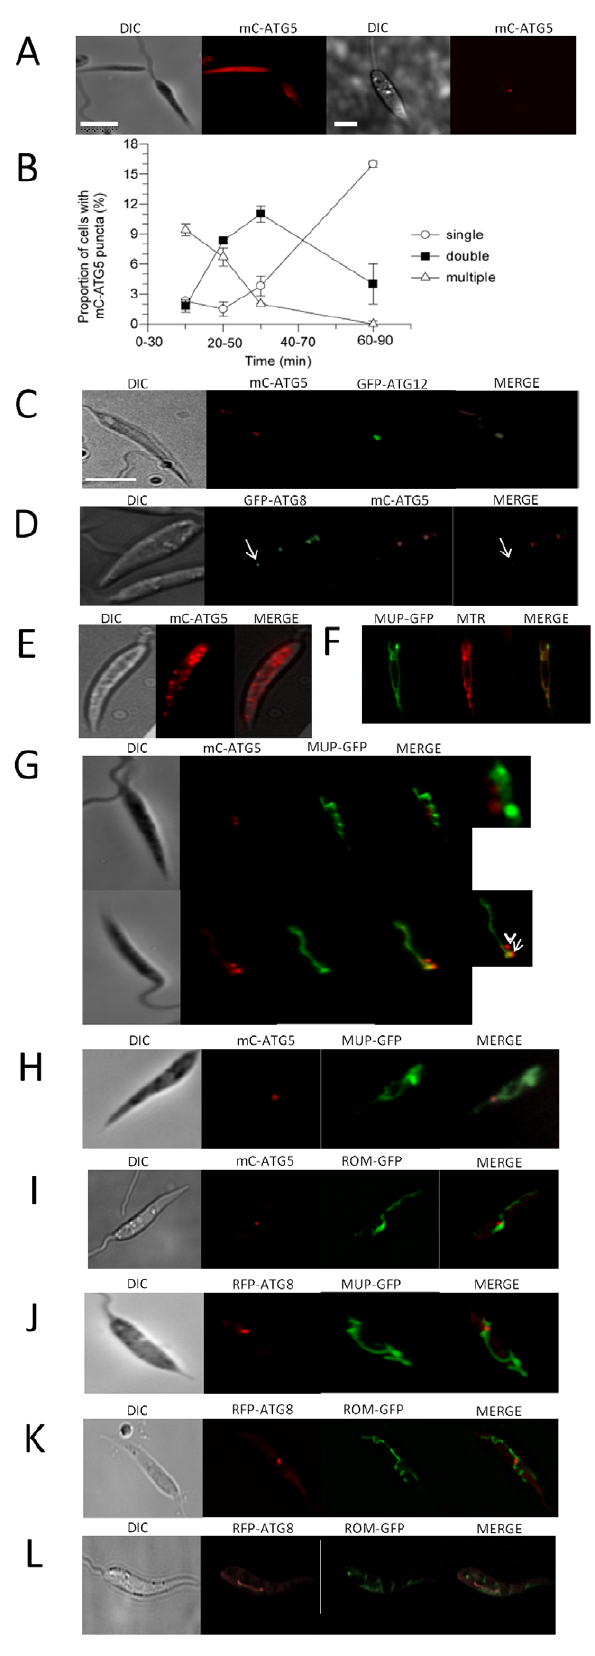
Figure 3. ATG5 puncta in L. major promastigotes. (A) The occurrence of mC-ATG5 puncta in WT L. major promastigotes expressing mC-ATG5 incubated in nutrient-rich medium at log phase at 26 u C. (B) The multiplicity of puncta in promastigotes expressing mC- ATG5 after starvation for up to 1 h in PBS at 26 u C. The time ranges indicated reflect the starvation period together with the 30 min period during which the observations on the microscope were undertaken. (C) Co-labelling of puncta with mC-ATG5 and GFP-ATG12 co-expressed in promastigotes incubated in PBS for 2 h at 26 u C. (D) In nutrient-rich medium, GFP-ATG8 punctum without mC-ATG5 staining is arrowed. (E) Incubated in PBS for 30 min at 26 u C. (F) In nutrient-rich medium at 26 u C. (G) Incubated in PBS for 30 min at 26 u C, the small panels are enlargements of the merged panels. (H–I) Promastigotes in nutrient-rich medium. (J–K) Promastigotes at late log phase in nutrient-rich conditions. (L) Promastigotes at stationary phase in nutrient-rich conditions. Scale bar throughout, 10 m